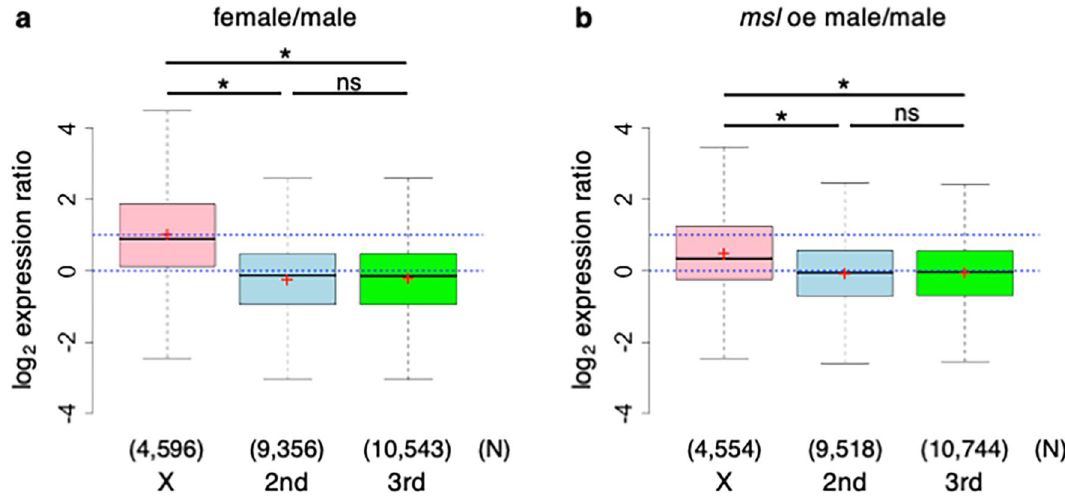
Figure 4. Overexpression of msl-1 , msl-2, msl-3 , and roX2 induces hyperactivation of X-linked genes in male PGCs. ( a ) Log 2 expression ratio of transcripts from genes on the X (pink), second (light blue), and third chromosomes (lime green) between female and male PGCs (female/male) at embryonic stages 15–16. Each box plot represents values as in Fig. 1a. Mean values for the X, second, and third chromosomes were 1.03, − 0.23, and − 0.21, respectively. Blue dotted lines indicate log 2 expression ratios of 0 and 1. Significance was calculated by two-sided Mann–Whitney U test (*, P < 0.05; ns, not significant). Transcripts for which TPM was zero in all samples were excluded from this analysis. N: number of the transcripts examined. ( b ) Log 2 expression ratio of transcripts from genes on the X (pink), second (light blue), and third chromosomes (lime green) between msl oe male PGCs and male PGCs ( msl oe male/male) at embryonic stages 15–16. Each box plot represents values as in Fig. 1a. Mean values for the X, second, and third chromosomes were 0.51, − 0.06, and − 0.04, respectively. Blue dotted lines indicate log 2 expression ratios of 0 and 1. Significance was calculated by two-sided Mann–Whitney U test (*, P < 0.05; ns, not significant). Transcripts for which TPM was zero in all samples were excluded from this analysis. N: number of transcripts examined. Expression ratio of the autosomal genes in msl oe male/male was higher than in female/male in ( a ) ( P values, calculated by two-sided Mann–Whitney U test for the second and third chromosomes, were < 0.05), but the effect sizes calculated by Cliff’s Delta for the second and third chromosomes were statistically negligible (0.07 and 0.08, respectively) 51 . Expression ratio of X-linked genes in msl oe male/male was significantly lower than in female/male in ( a ) ( P values, calculated by two-sided Mann– Whitney U test, were < 0.05), and the effect size was non-negligible